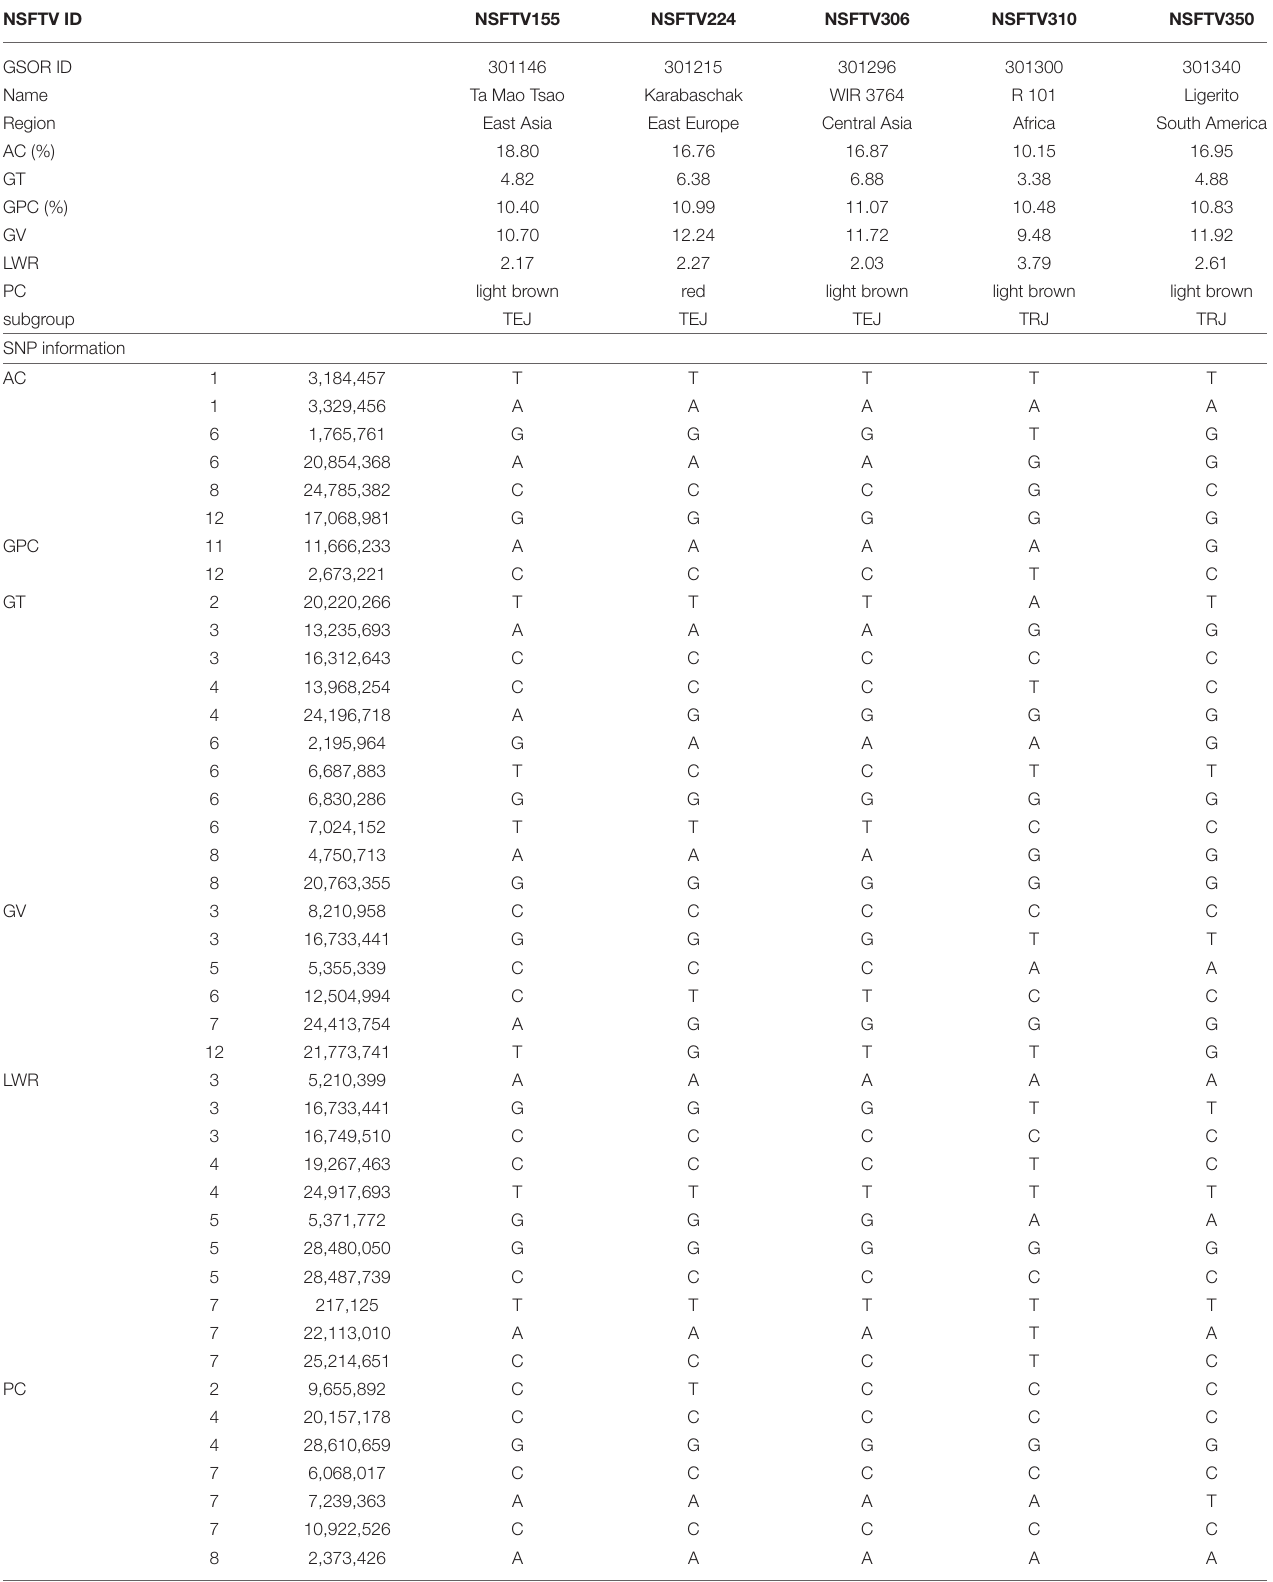
TABLE 3 | Germplasm lines selected from the rice diversity panel 1 (RDP1) population in this